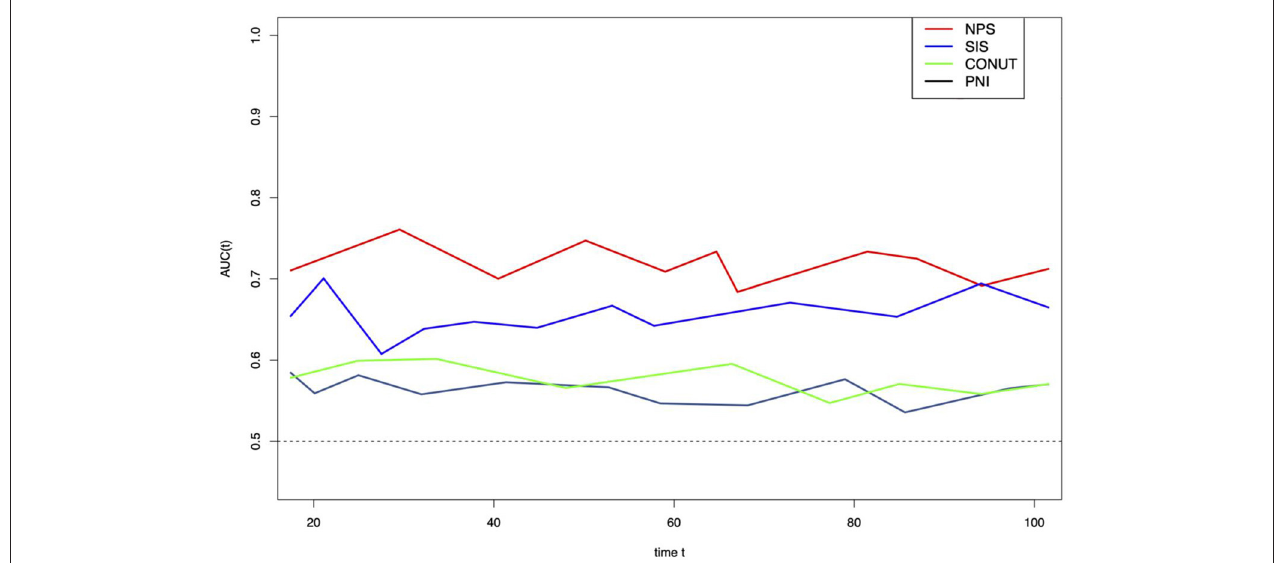
FIGURE 4 | Time-dependent ROC curves of NPS, SIS, CONUT, and PNI for prediction of overall survival. The horizontal axis represents year after surgery, and the vertical axis represents the estimated AUC for survival at the time of interest. NPS, naples prognostic score; SIS, systemic inflammation score; CONUT, controlling nutritional status; PNI, prognostic nutritional